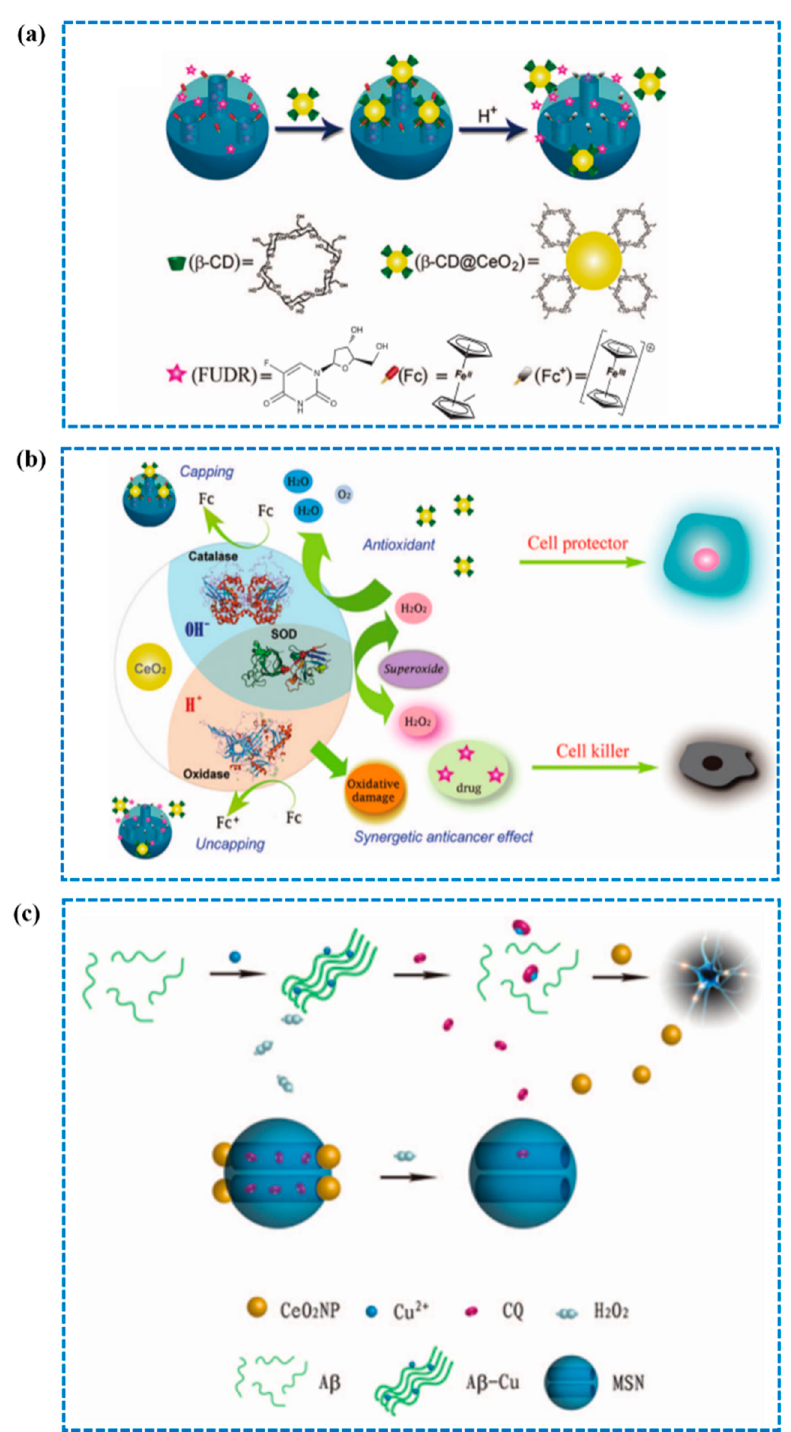
Figure 5. Design of nanoscale cerium oxide anticancer drug carrier. ( a ) Nanoscale cerium oxide nanocarrier framework for anticancer drugs [75]; ( b ) anticancer mechanism [75]; ( c ) anti-Alz- heimer’s nanocarrier framework [75]. Copyright 2013 Royal Society of